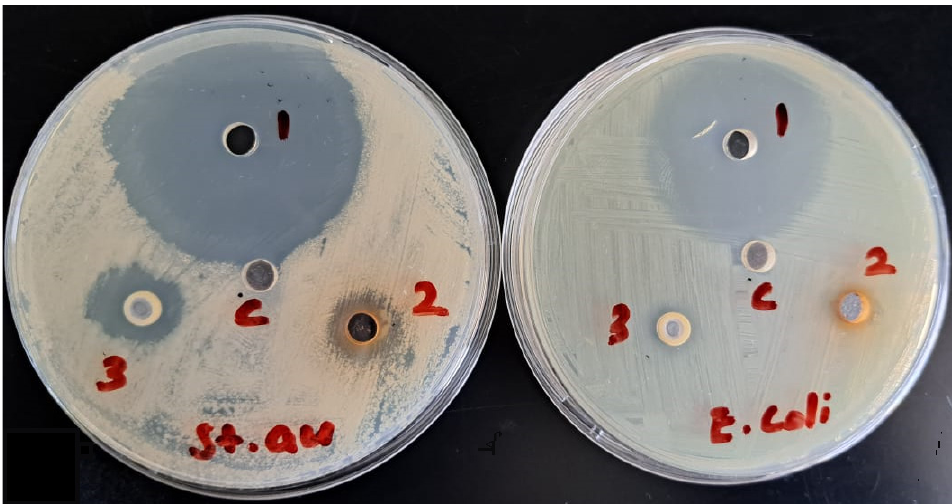
Figure 1. Antibacterial activity of essential oil (spot 3); ethanolic extract (spot 2); and moxifloxacin (spot 1) against S. aureus and E. coli. Control (5% DMSO) is marked “C”.